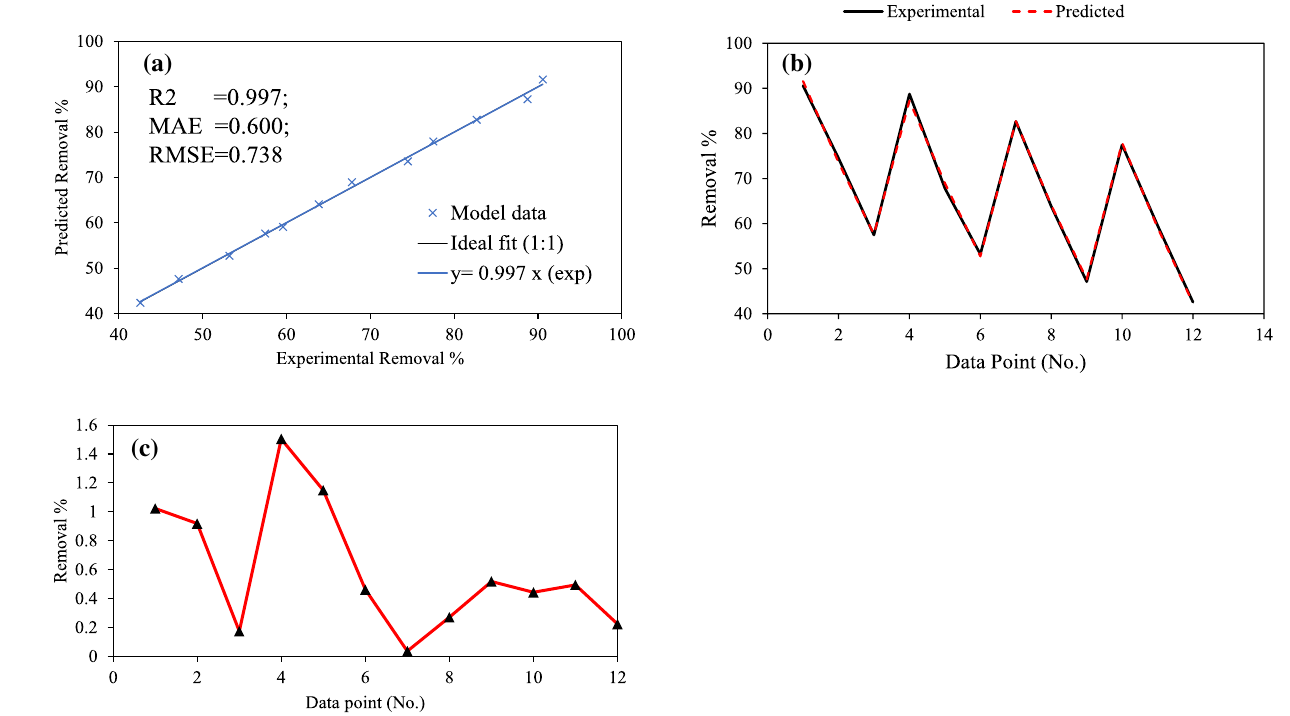
Fig. 2 Performance of the R